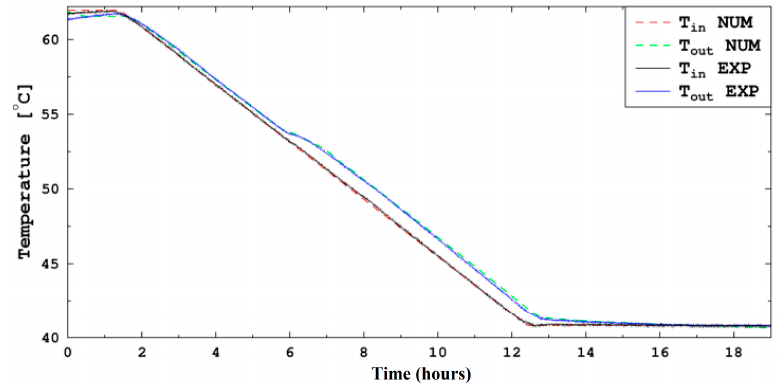
Figure 8. Discharge mode from 62.1 to 40.8 ◦ C at 2 ◦ C/h and 194 L/h. The global energy balance for both experiments is synthetized in Table 6